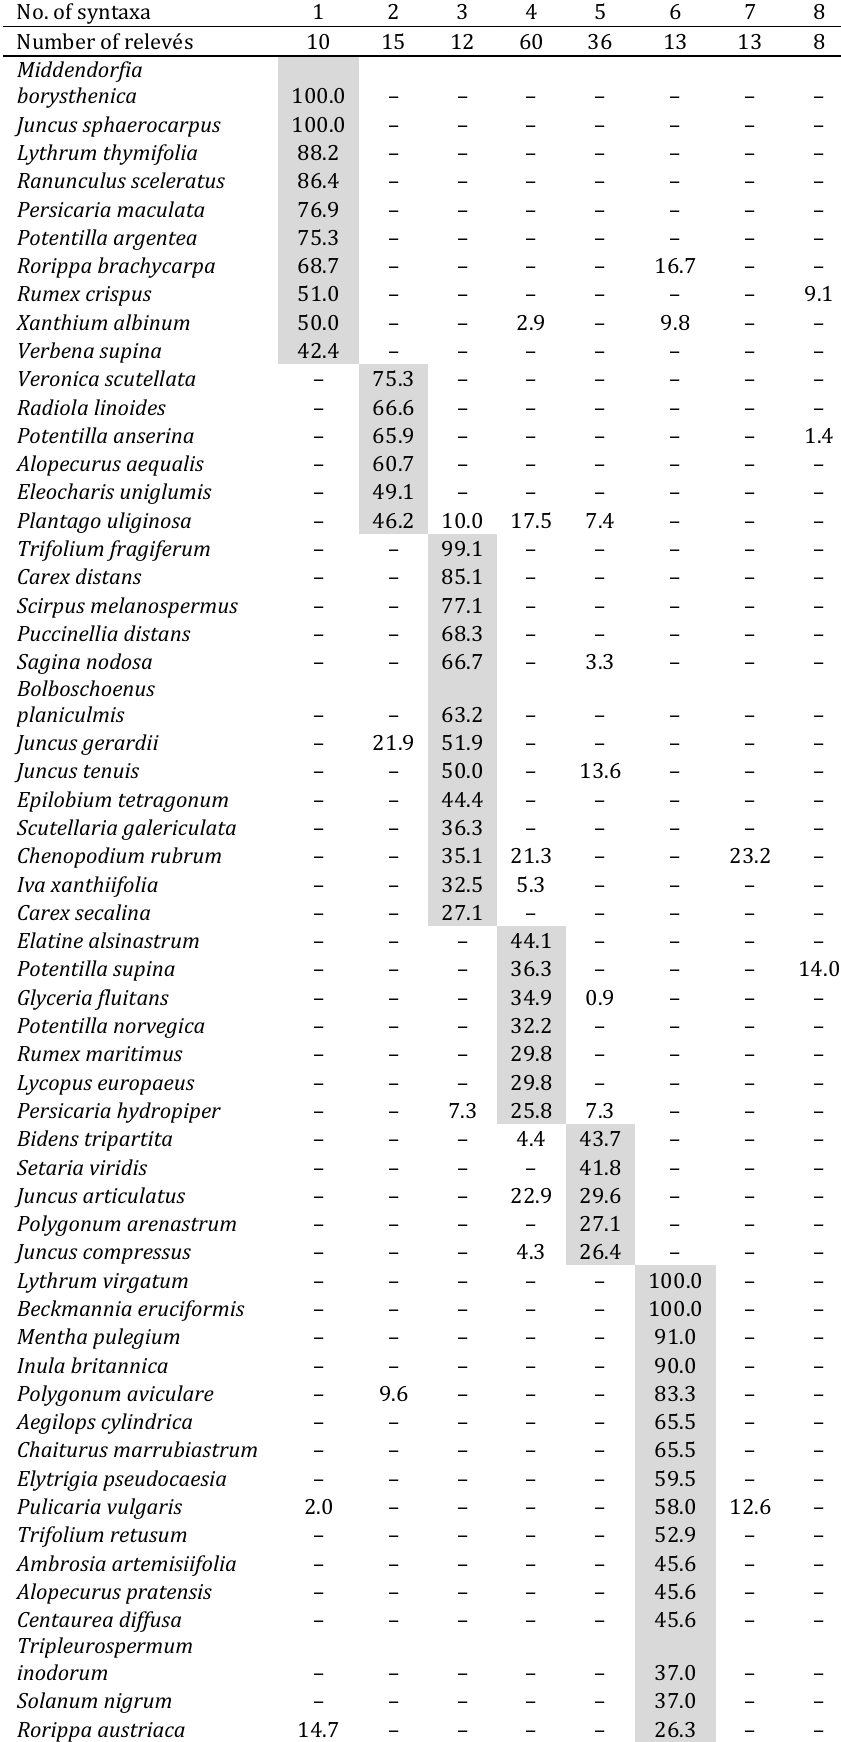
Table 1. Synoptic table of the class Isoëto-Nanojuncetea No. of syntaxa Number of relevés